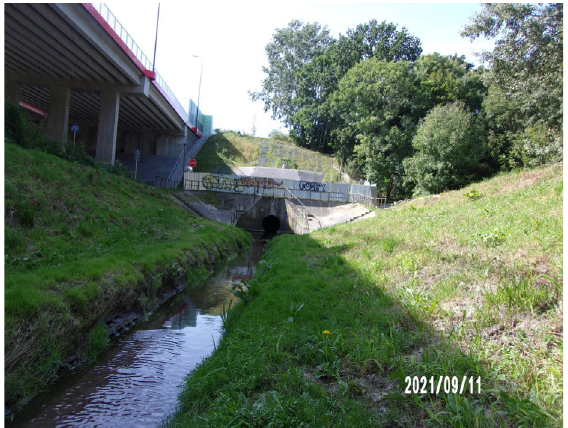
Figure A7. A view of the outflow from Ursynów rain collector measuring 4 metres in diameter, with a flow of 8 m 3 s − 1 (source: own).